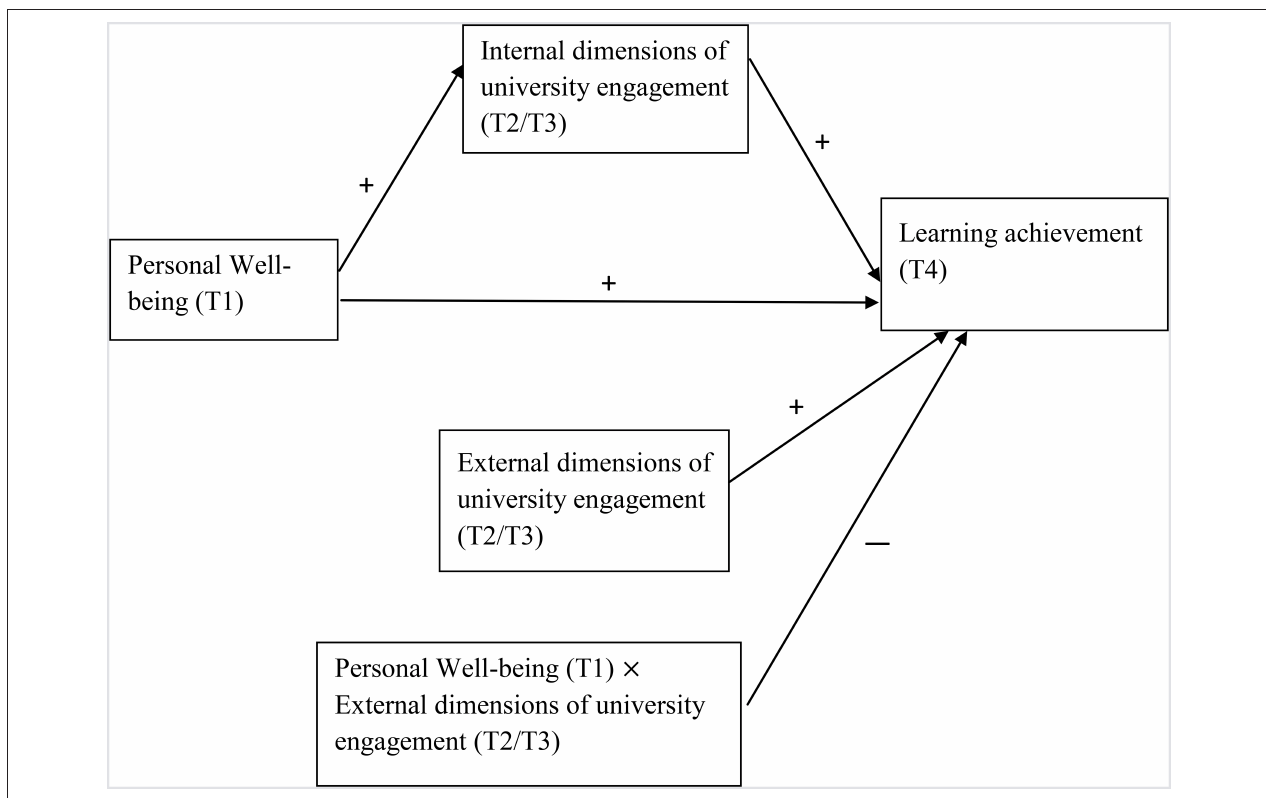
FIGURE 1 | Hypothesized relationships among personal well-being, learning achievement, internal, and external dimensions of university engagement. T1 = Time 1; T2 = Time 2; T3 = Time 3; T4 = Time 4.